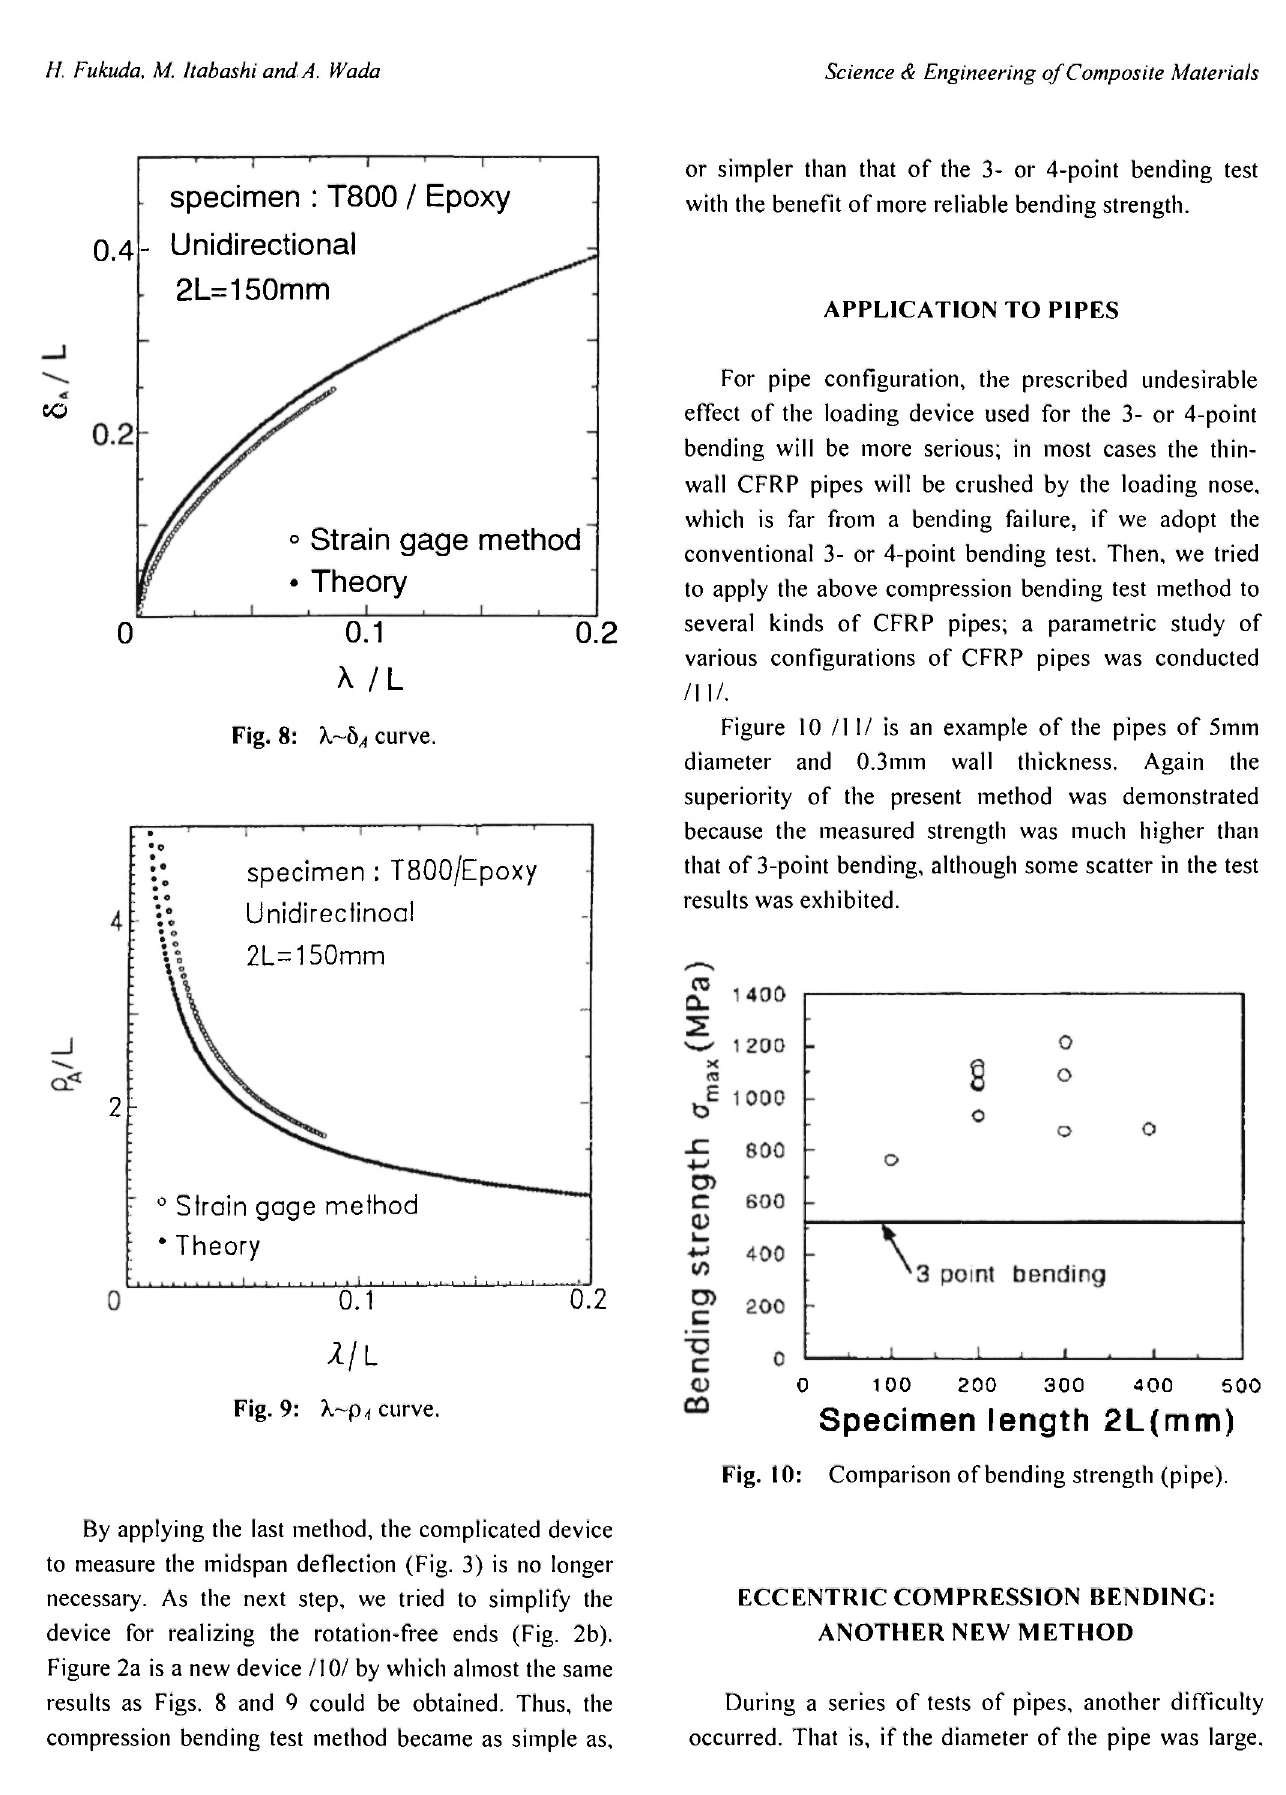
Fig. 9: λ-p,) curve.